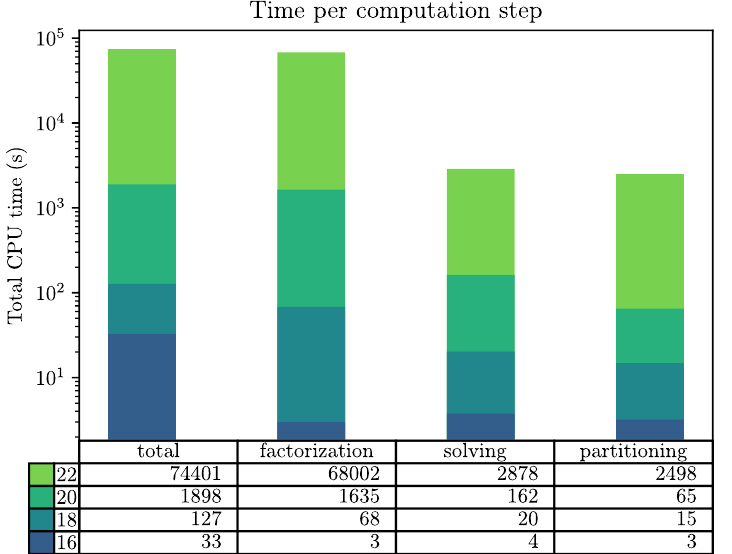
Figure 5: Time per computation step (in s ), for various system sizes. The execution times are obtained for the computation of 10 eigenpairs using STRUMPACK with the full MPI strategy, and are averaged over 5